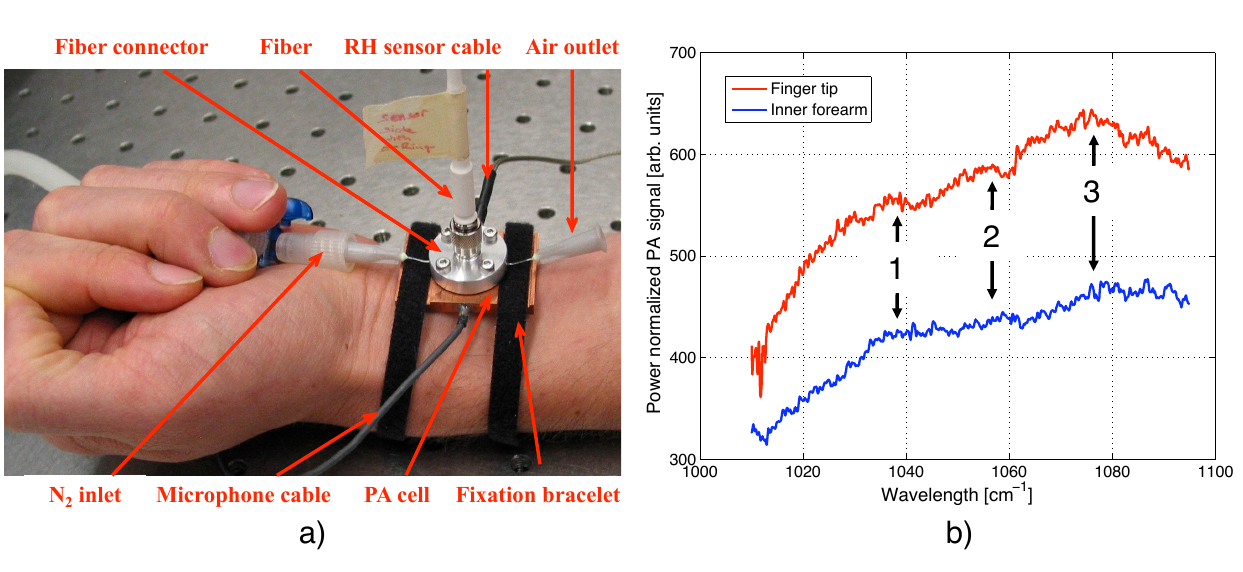
Table 1. Vibrational absorption bands of skin found within the tuning range of the QCL according to literature [30–33]. Used abbreviations: v = very, m = medium, w = weak and ν = stretch. The numbering 1 to 3 indicates their possible contribution to the absorption peaks observed in the skin spectra displayed in Figure